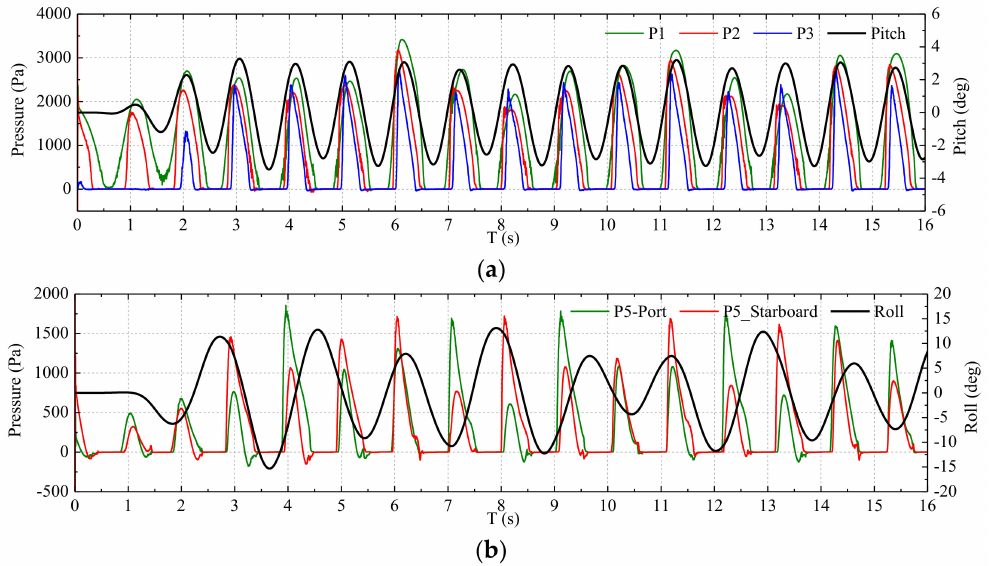
Figure 27. Impact pressure and pitch & roll for the case of ship sail in asymmetric wave field: ( a ) sensors at centerline of bow; ( b ) sensors at P5.